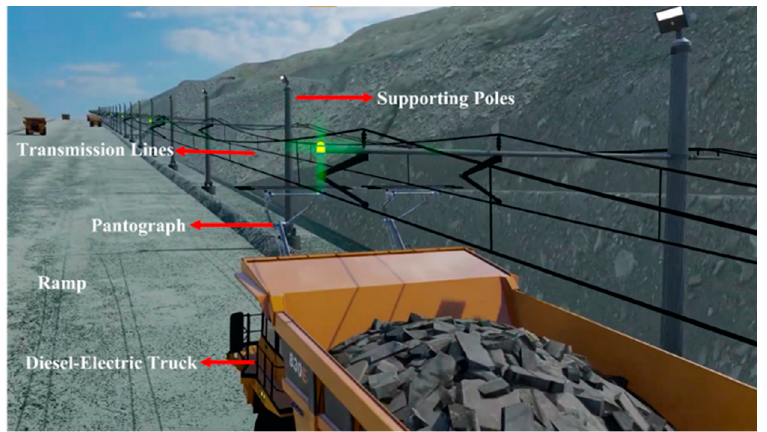
Figure 12. Truck with Trolley Assist capability operating on ramp (Source: ABB).